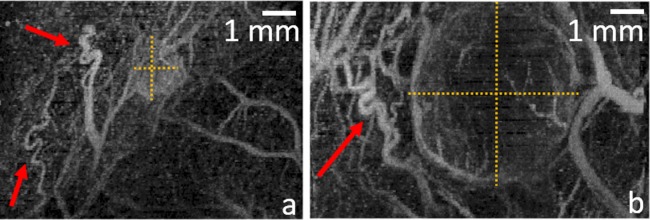
(Color online) example of acoustic angiography maximum intensity projections around tumors (tumor size denoted with dashed yellow lines) in a rat fibrosarcoma allograft, with tortuous angiogenesis extending beyond the tumor margins (red arrows).The small tumor (a) is also shown to be more enhanced, denoting its higher perfusion compared to the larger tumor (b).